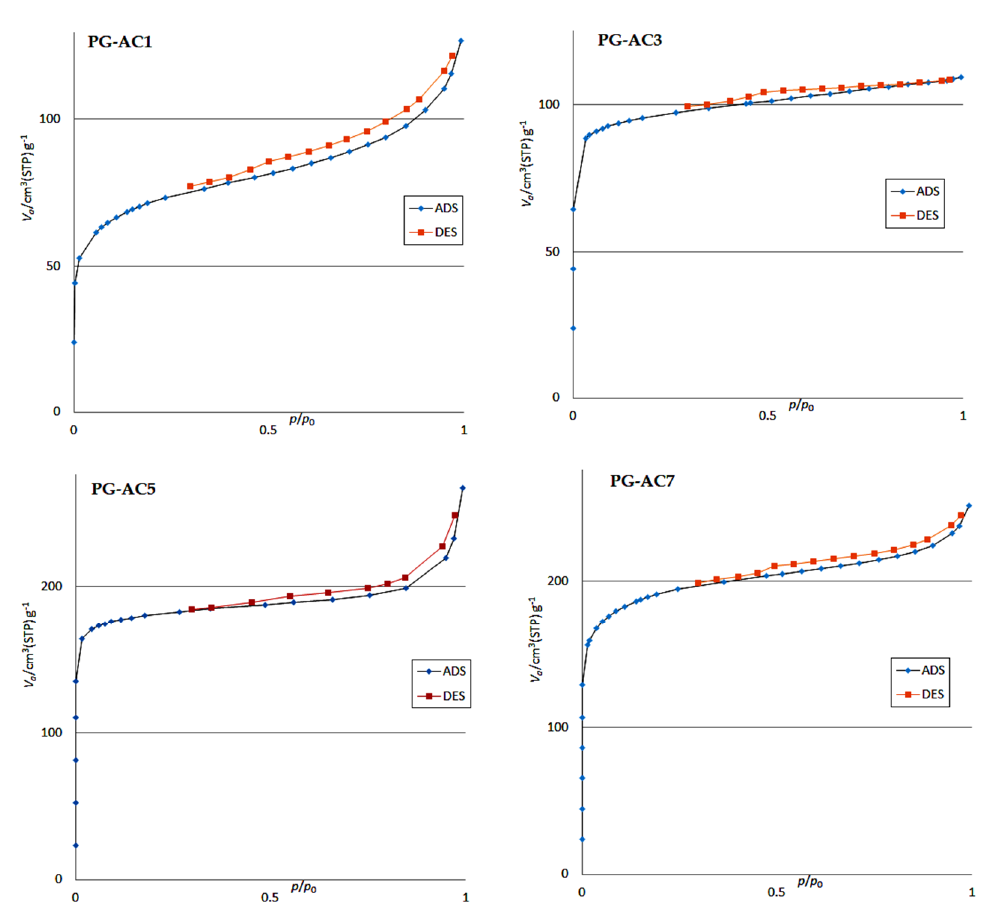
Figure 1. Adsorption-desorption isotherm for BET analysis with different ratios of NaOH:PG-AC (PG-AC1, 1:1), (PG-AC3, 1:3), (PG-AC5, 1:5) and (PG-AC7, 1:7).